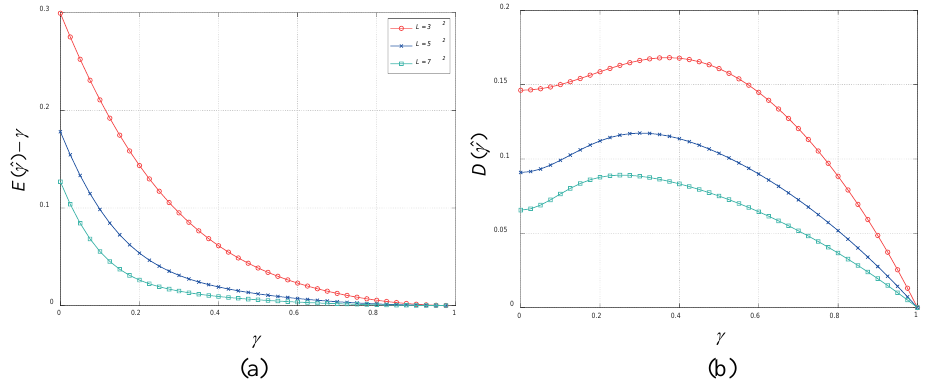
Figure 1. ( a ) The difference between the expectation of sample coherence magnitude and true coherence γ for different numbers of looks L . ( b ) The standard deviation of sample coherence magnitude D ( ˆ γ ) for different numbers of looks L